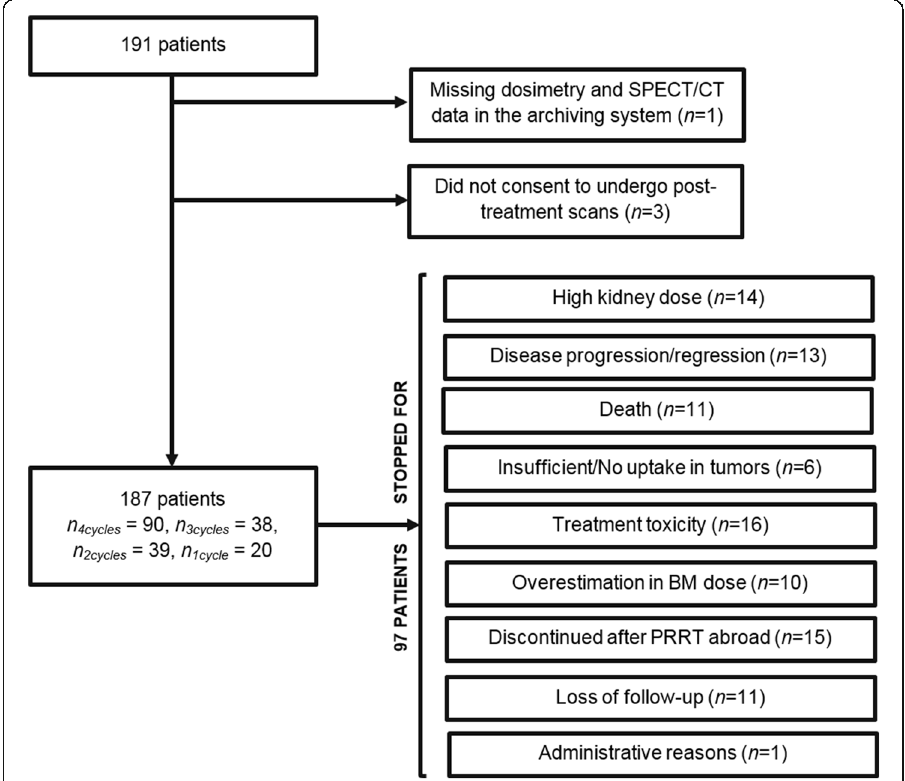
Fig. 1 Chart of patient inclusion. Legend: Chart of patient inclusion. n 4 cycles , n 3 cycles, n 2 cycles and n 1 cycle represent the number of patients included in the study who have completed respectively 4, 3, 2, or